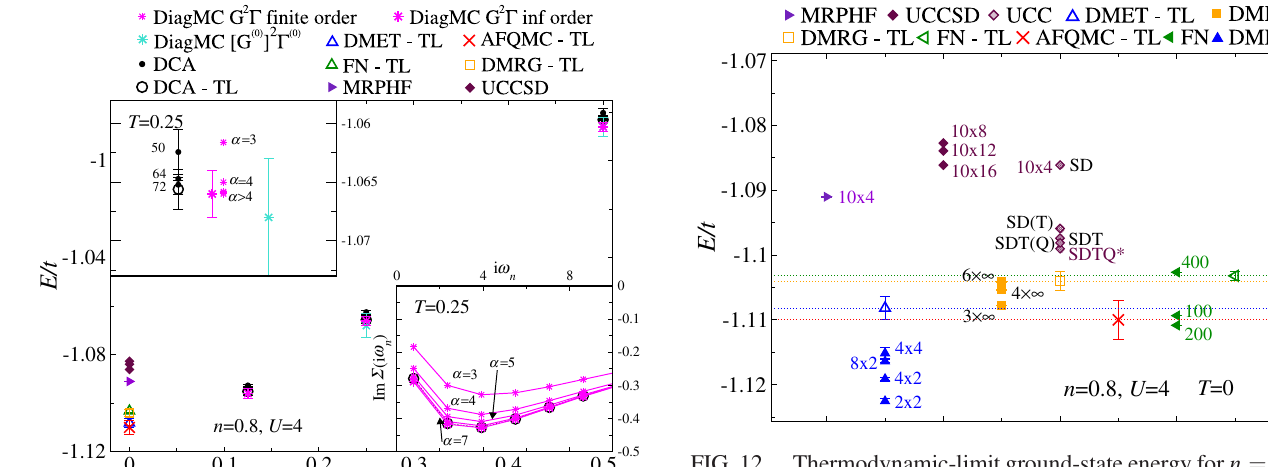
FIG. 12. Thermodynamic-limit ground-state energy for n ¼ 0 . 8 for U=t ¼ 4 as obtained by various algorithms (open symbols). Also shown are the finite-size systems (filled symbols with adjacent labels) from which the thermodynamic-limit ground- state energy was obtained. Data are from AFQMC (red crosses), DMET (blue triangles), UCCSD (maroon diamonds), UCC on a 10 × 4 lattice (shaded diamonds), MRPHF (purple triangles), DMRG (orange squares), and FN (green triangles). Horizontal thin dotted lines show the best estimates for the ground-state